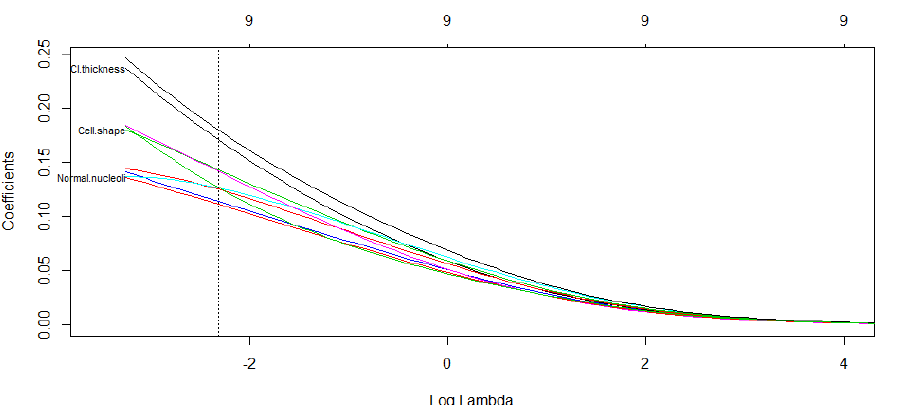
Figure 12. Coefficients for our LR-lasso model for the breast cancer data. The dotted vertical line in the plot represents the λ with misclassification error (MCE) within one standard error of the minimum MCE.